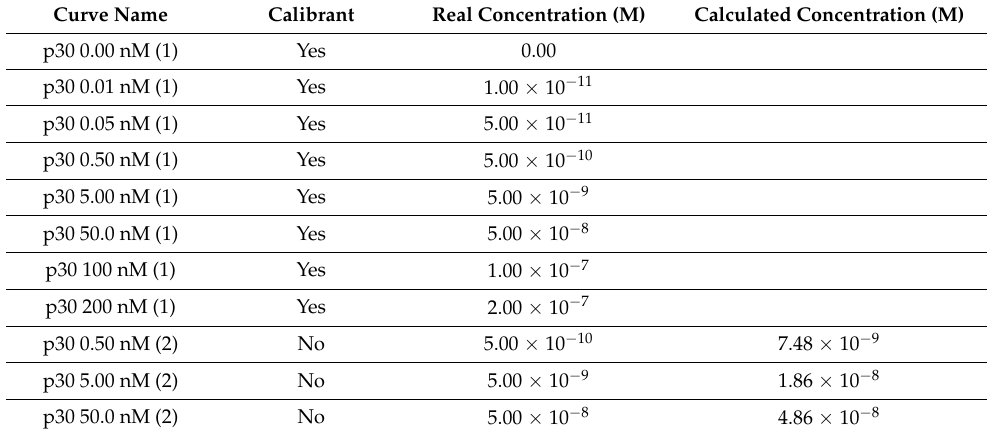
Table 3. Results of the concentration through calibration (CTC) analysis on p30